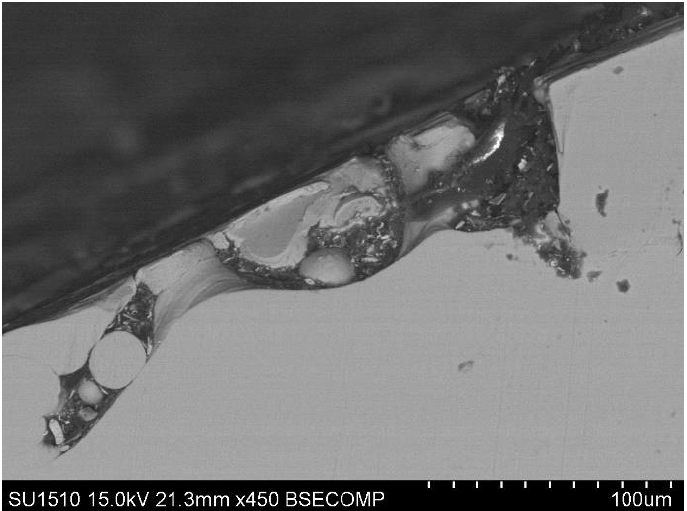
Figure 3. Electron microscopic image of the cross section of sample E1 after burnishing. Modified surface morphology and unchanged internal pore defects are observable.